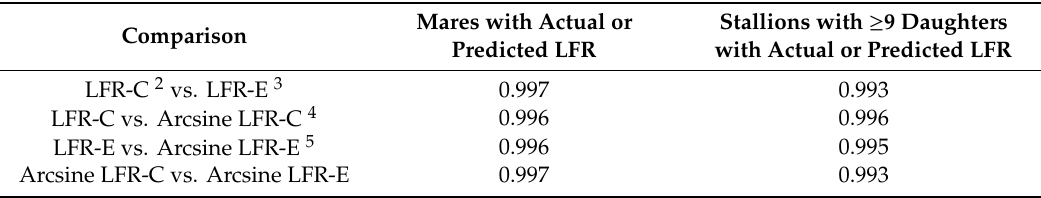
Table 5. Rank correlation coe ffi cients between standardized EBVs obtained for di ff erent expression of lifetime fertility rate (LFR 1 ) in Italian Heavy Draught Horse mares with records ( n = 3033) or stallions with at a minimum accuracy of 0.65 ( n =